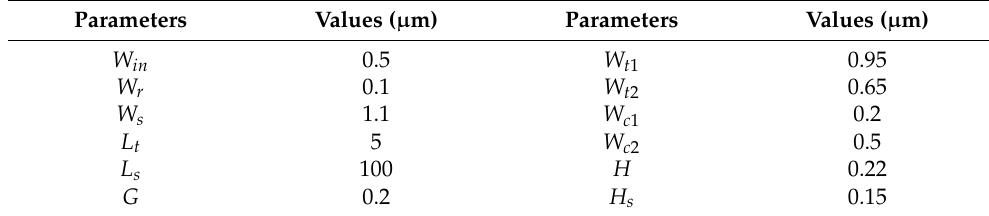
Figure 1. ( a ) The schematic diagram of the proposed PSR. ( b ) The 3D schematic diagram of the APR. ( c ) The calculated effective refractive indices of the first three modes as a function of the width variation for both slab and rib waveguides. Table 1. Parameters and values of the